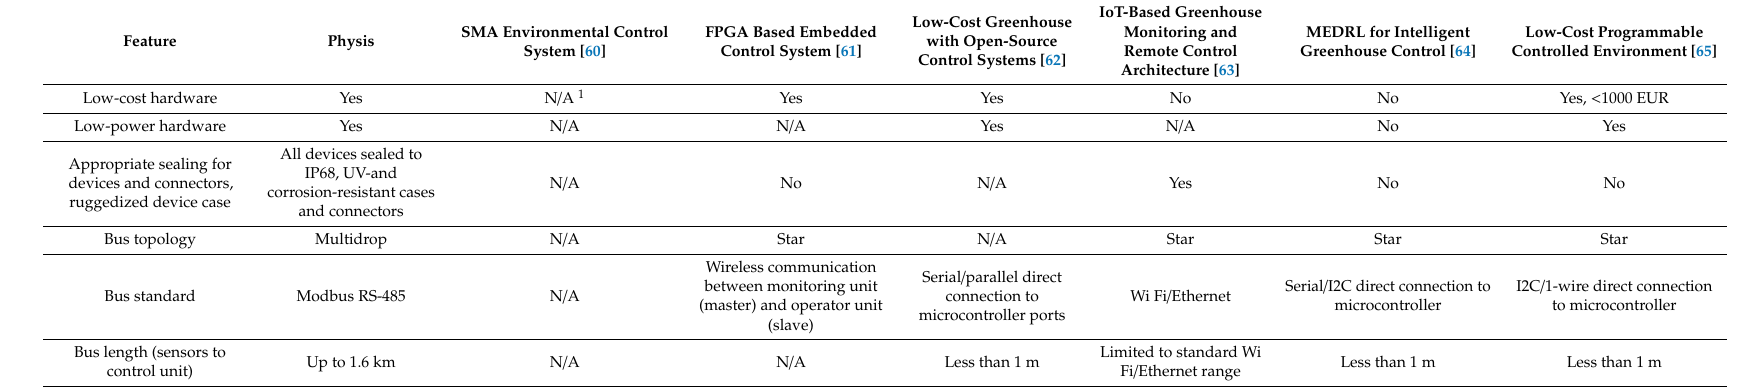
Table 3. Comparative study between Physis platform and other systems presented in